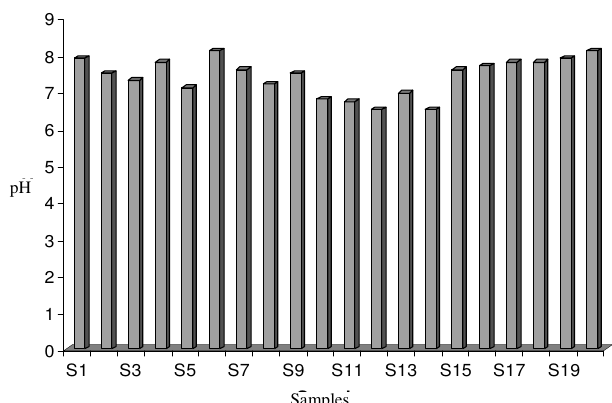
Figure 1 . pH of water samples collected from Kandarvakottai (S1 to S10) and Karambakudi (S11 to S20) areas.